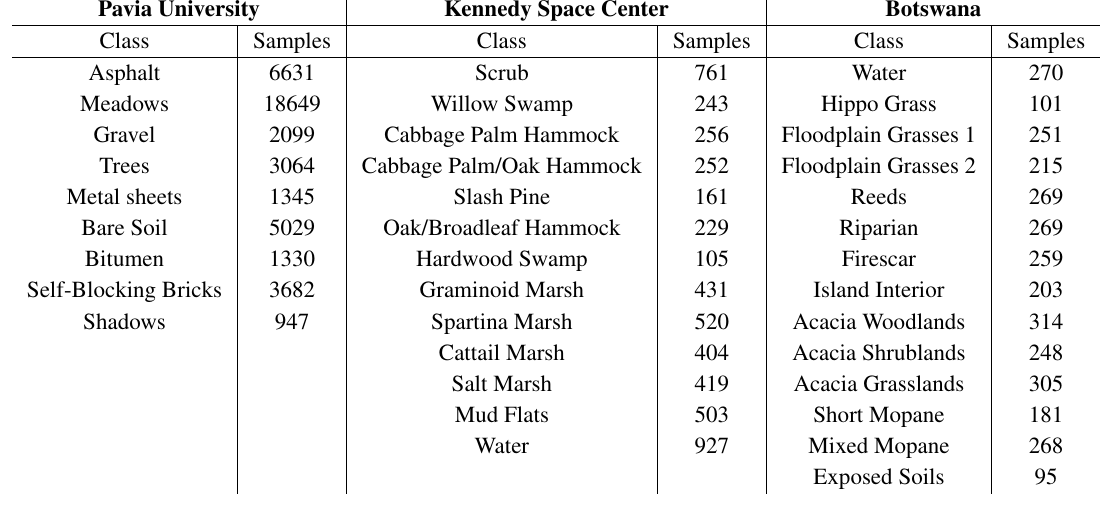
Table 1. Class distribution samples corresponding to the hyperspectral datasets: Pavia University, Kennedy Space Center, and